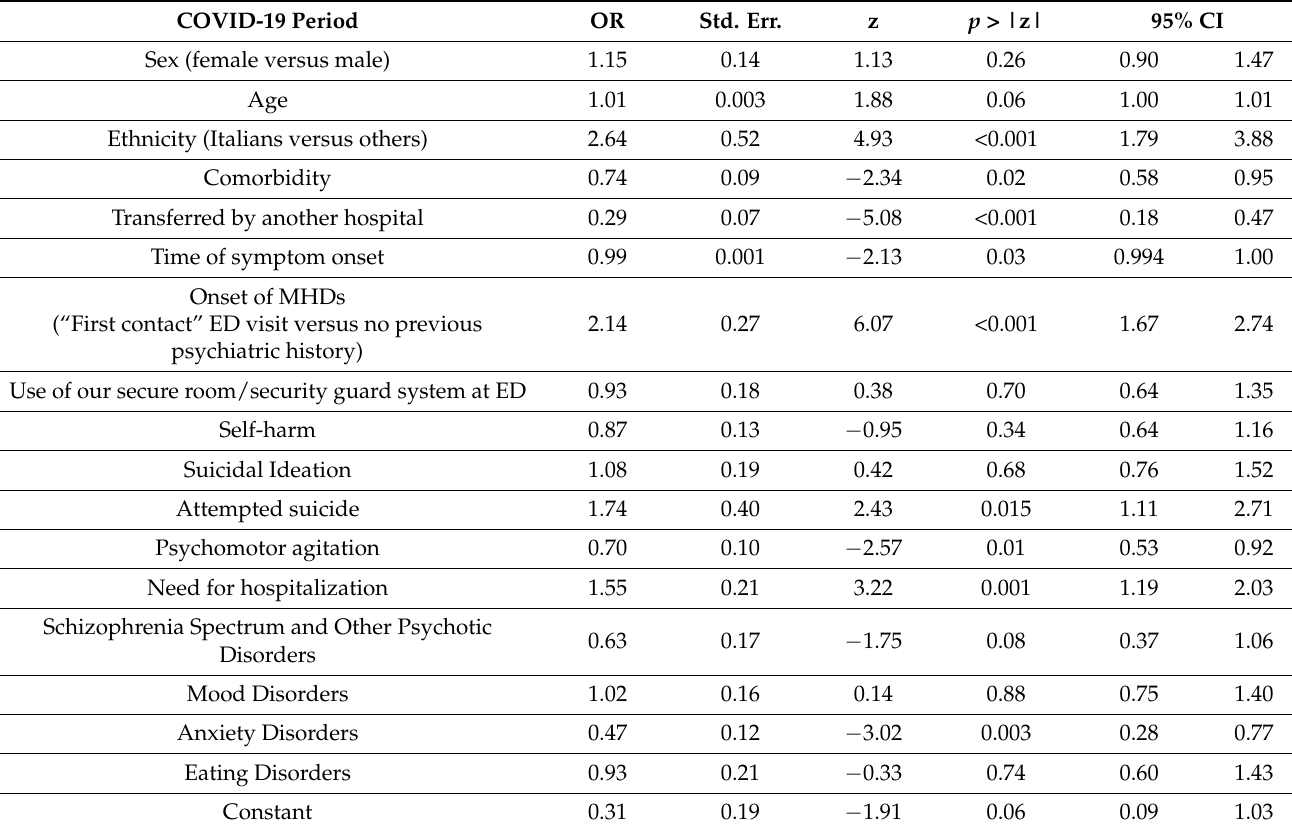
Table 3. Multivariable logistic regression analysis exploring risk factors associated with ED visits for MHDs in adolescents during the COVID-19